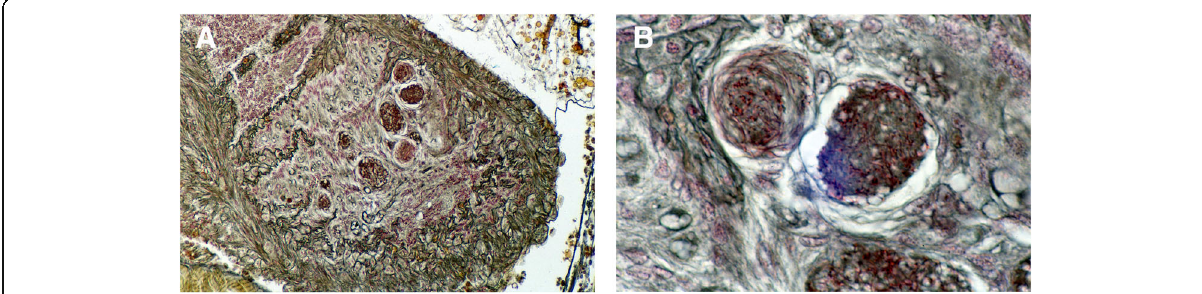
Fig. 10 Storage of spermatozoa in glandular tissue of the buthid Centruroides barbudensis . ( a ) Part of the proximal glandular region of the ovarian tube containing piles of spermatozoa. ( b ) Details of sperm masses surrounded by glandular cells